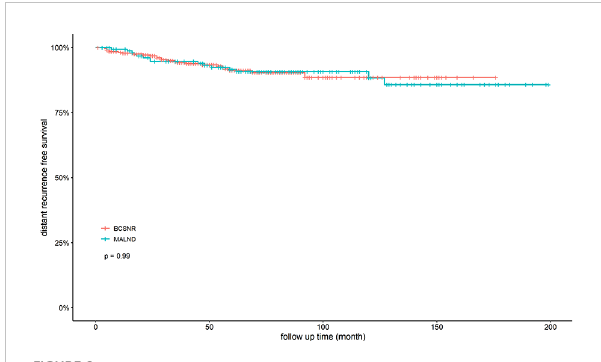
FIGURE 4 Breast cancer speci fi c survival for all patients with BCSNR and